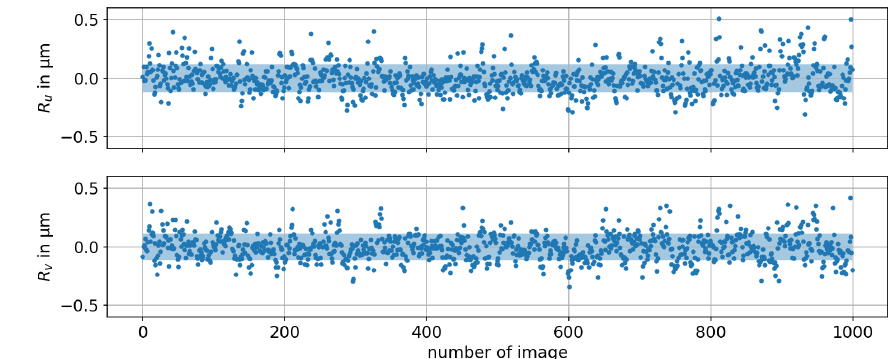
Figure 5. Detected centroid positions over 1000 images for one detection plane. The blue area visualizes the detected standard deviation in both directions ( σ u = 120nm, σ v = 113nm).